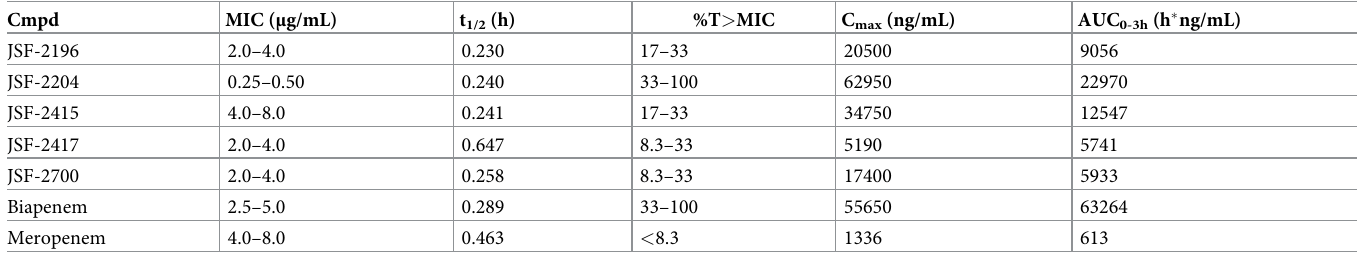
Table 1. Summary of in vitro efficacy and mouse PK data for select